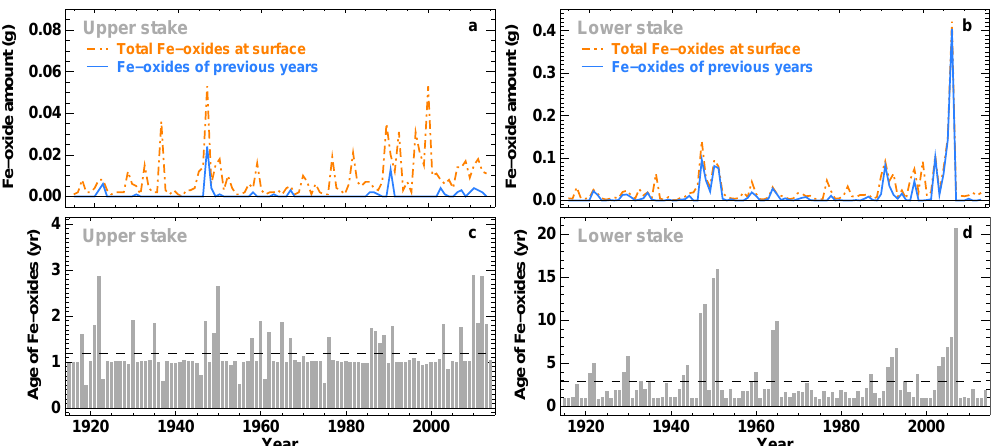
Figure 5. Total Fe-oxide amount of the surface snow layer of each year and the amount of Fe-oxides of previous years emerging at the surface through melt-out over the period 1914–2014 for (a) the upper and (b) the lower stake. (c) and (d) illustrate the age of the oldest mineral dust present at the glacier surface for each year for both sites. Note that the scales for the upper and lower site are different.